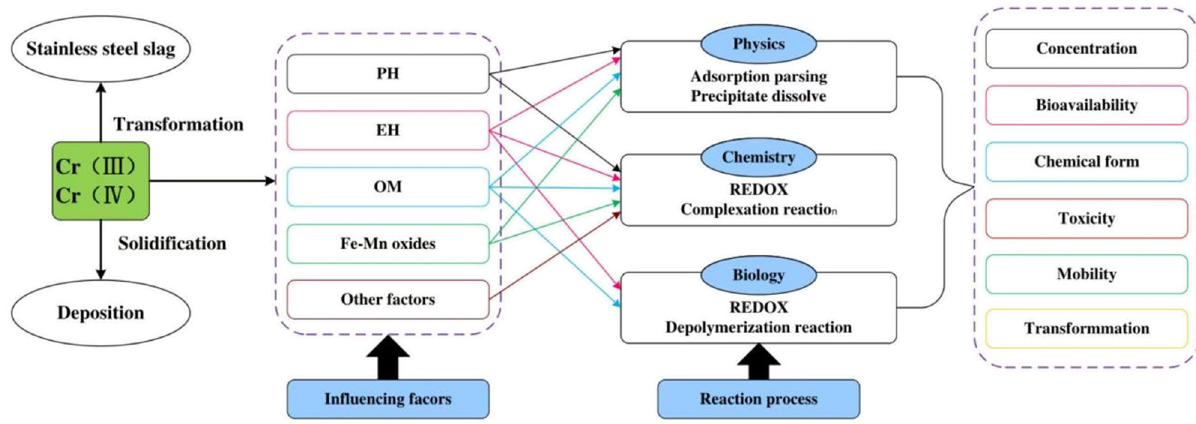
Figure 1: Schematic diagram of in fl uencing factors for the migration and transformation behavior of Cr in